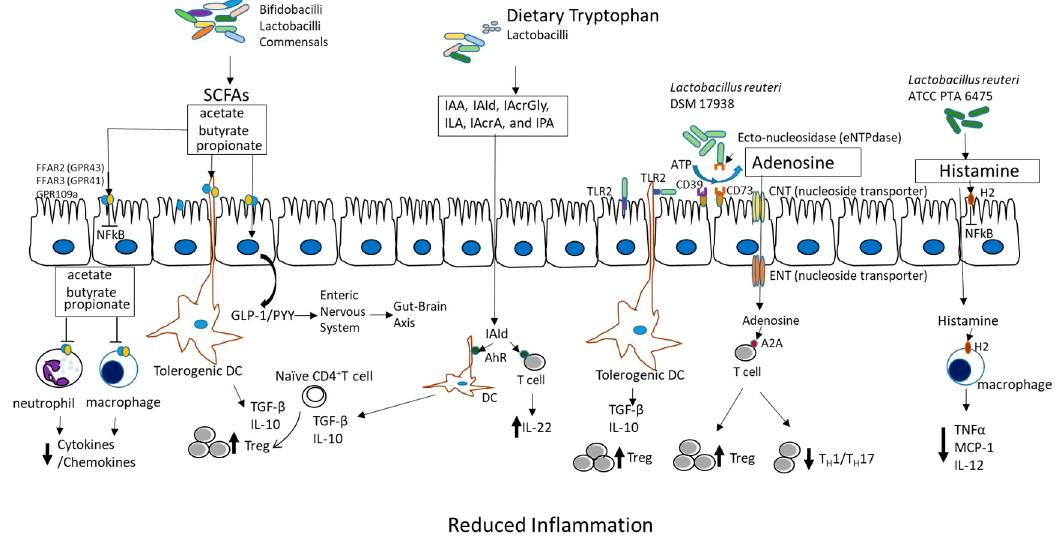
Figure 1. Critical metabolites produced by probiotics which have anti-inflammatory functions. SCFAs (acetate, butyrate, and propionate) produced by bifidobacilli, lactobacilli, and commensals bind and activate receptors (FFAR2, FFAR3, or GPR109a) on intestinal epithelial cells to inhibit the nuclear factor kappa-light-chain-enhancer of activated B cells (NF- κ B) pathway to prevent inflammation. They also inhibit histone deacetylases to promote accumulation of Tregs and may release GLP1/PYY to act on the enteric nervous system and the CNS to affect energy homeostasis and gut motility. SCFAs also induce tolerogenic DC, which educate naïve CD4 + T cells to differentiate into Tregs. These actions inhibit cytokine production by neutrophils and macrophages via interaction with receptors. Dietary tryptophan and probiotic-produced indole derivatives interact with AhR expressed on immune cells to produce anti-inflammatory effects. L. reuteri 17938 promotes adenosine generation, most likely by an ectonuclease present on the probiotic itself and on intestinal epithelial cells. Adenosine and its derivative inosine interact with adenosine receptor-2A located on T cells to promote Treg functions and inhibit inflammatory T H 1 and T H 17 subsets. Histamine produced by L. reuteri 6475 interacts with H 2 presented on intestinal epithelial cells and macrophages to reduce levels of proinflammatory cytokines (TNF- α , MCP-1, and IL-12). In summary, the critical metabolites produced by probiotics generate anti-inflammatory effects during diseases. Abbreviations: SCFAs: short-chain fatty acids; FFARs: free fatty acid receptors; GPRs: G-binding protein receptors; NF- κ B: nuclear factor kappa-light-chain-enhancer of activated B cells; GLP1: glucagon-like protein-1; PYY: peptide tyrosine tyrosine; CNS: central nervous system; AhR: aryl hydrocarbon receptor; T H 1 and T H 17: T helper cells; H 2 : histamine receptor 2; TNF- α : tumor necrosis factor alpha; MCP-1: monocyte chemoattractant protein-1; IL-12: interleukin-12 (illustration by Yuying Liu).